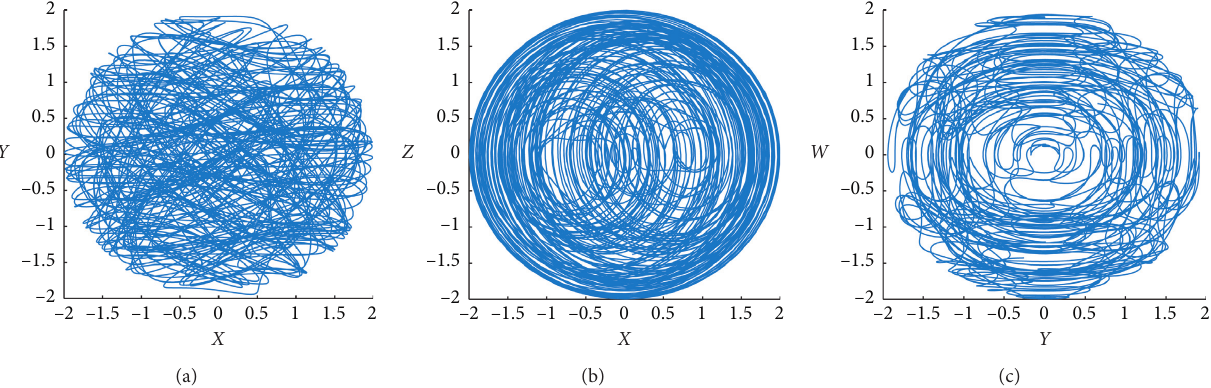
Figure 8: Phase portraits of Case 2 system on the different plane, with ( h,g,a, e ) � ( 0 . 5 , 10 , 6 , 5 . 5 ) and ( x plane. (b) x - z plane. (c) y-w